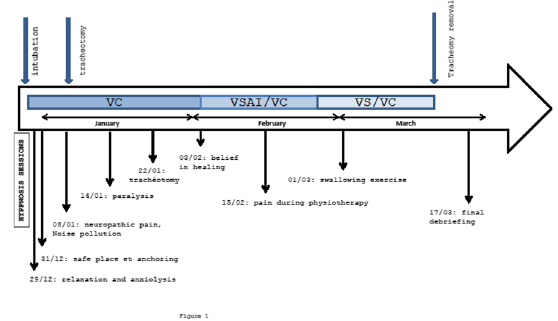
Fig. 1 Time distribution of the eight hypnotic sessions F‑111 Resuscitation Hypnosis: Benchmarks for Effective